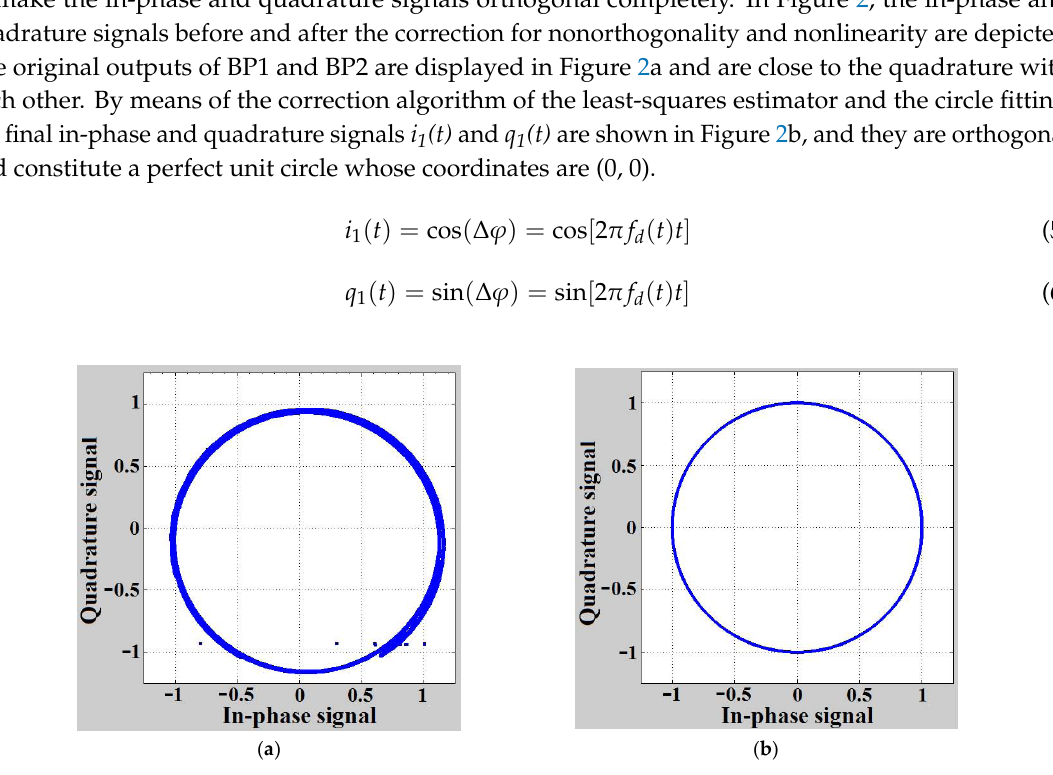
Figure 2. ( a ) The original set of in-phase signal i(t) and quadrature signal q(t) from BP1 and BP2; ( b ) the corrected signals i 1 (t) and q 1 (t) after the nonorthogonal correction algorithm.